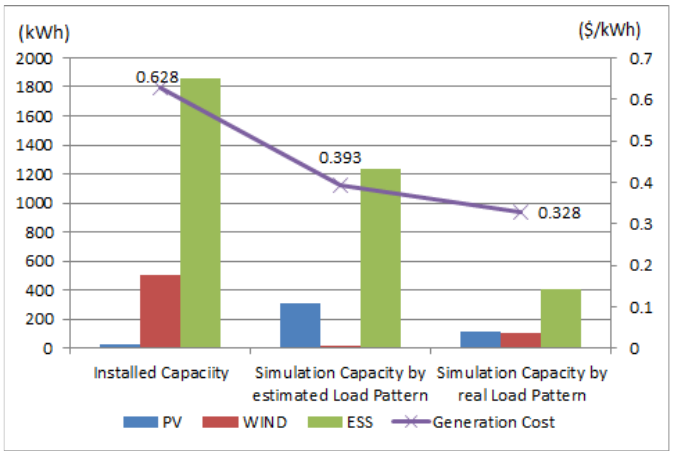
Figure 10. Economic effect ( y axis) of new estimation method for load pattern compared with installed and simulated ones ( x axis: different design methods) by real load pattern for for Island 5.